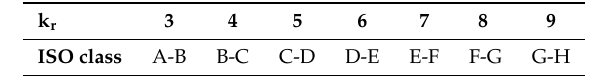
Table 1. Corresponding ISO 8608[99] class ranges for the different values of k r [98]. k r 3